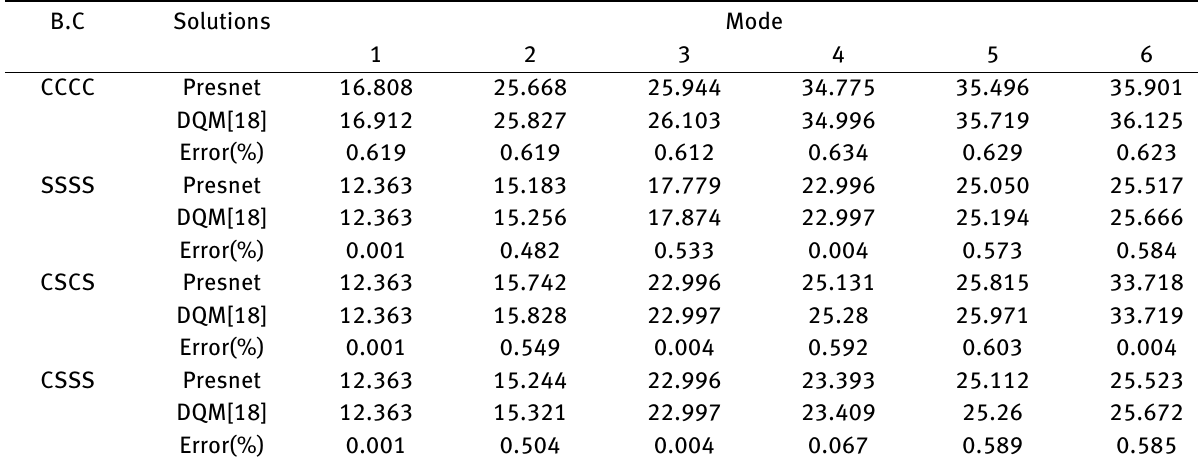
Table 2: Comparison of the frequency parameters Ω for a [0 ∘ /90 ∘ ] 5 laminated annular sector plate with different classical boundary condi- tions ( ϕ = π /3, a / b =0.1, h / b =0.2, E 1 / E 2